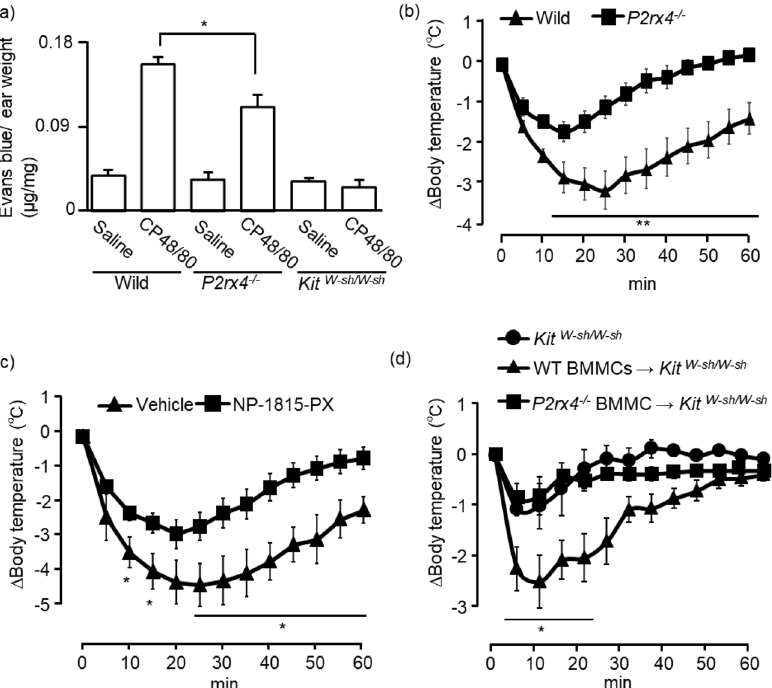
Figure 5. Role of P2X4R on pseudoallergic response induced by CP48/80 in mice. ( a ) WT, P2rx4 −/− , and Kit W-sh/W-sh mice were injected intravenously with Evans blue, and then the mouse ear was intradermally injected with saline or CP48/80 (100 ng/20 μL), and extravasated Evans blue dye was measured (n = 5). ( b ) WT or P2rx4 −/− mice were injected intravenously with CP48/80 (50 μg/100 μL), and rectal temperatures were measured every 5 min for 60 min (WT n = 8, P2rx4 −/− n = 7). ( c ) NP-1815-PX (10 mg/kg) intraperitoneally injected mice were injected intravenously with CP48/80 (50 μg/100 μL), and rectal temperatures were measured every 5 min for 60 min (saline n = 4, NP-1815-PX n = 8) ( d ) Kit W-sh/W-sh mice were reconstituted with WT (WT BMMCs → Kit W-sh/W-sh ; n = 4) or P2rx4 −/− ( P2rx4 −/− BMMC → Kit W-sh/W-sh ; n = 3) BMMCs. Reconstituted mice were injected intravenously with CP48/80 (50 μg/100 μL), and rectal temperatures were measured every 5 min for 60 min. Data are presented as the mean ± SEM. *P < 0.05, **P <